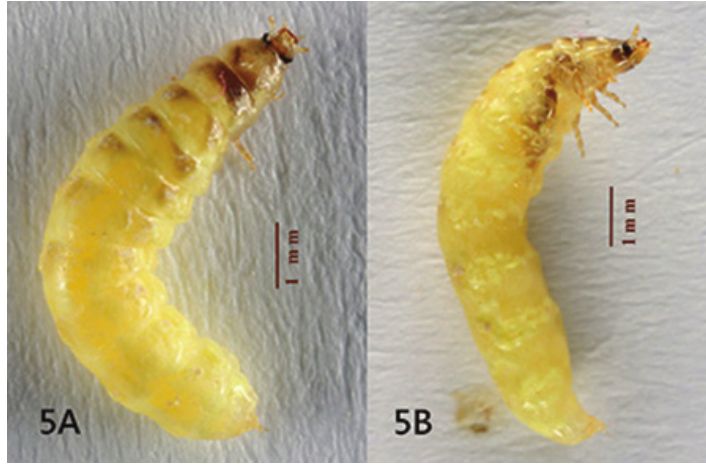
Figure 5. Oculogryphus chenghoiyanae sp. n., female, dorsal ( A ) and lateral ( B ) aspects.